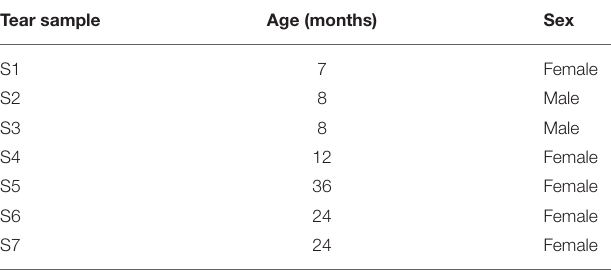
TABLE 1 | Age and sex of the sheep ( N = 7) from which tear samples were obtained. Tear sample Age (months)